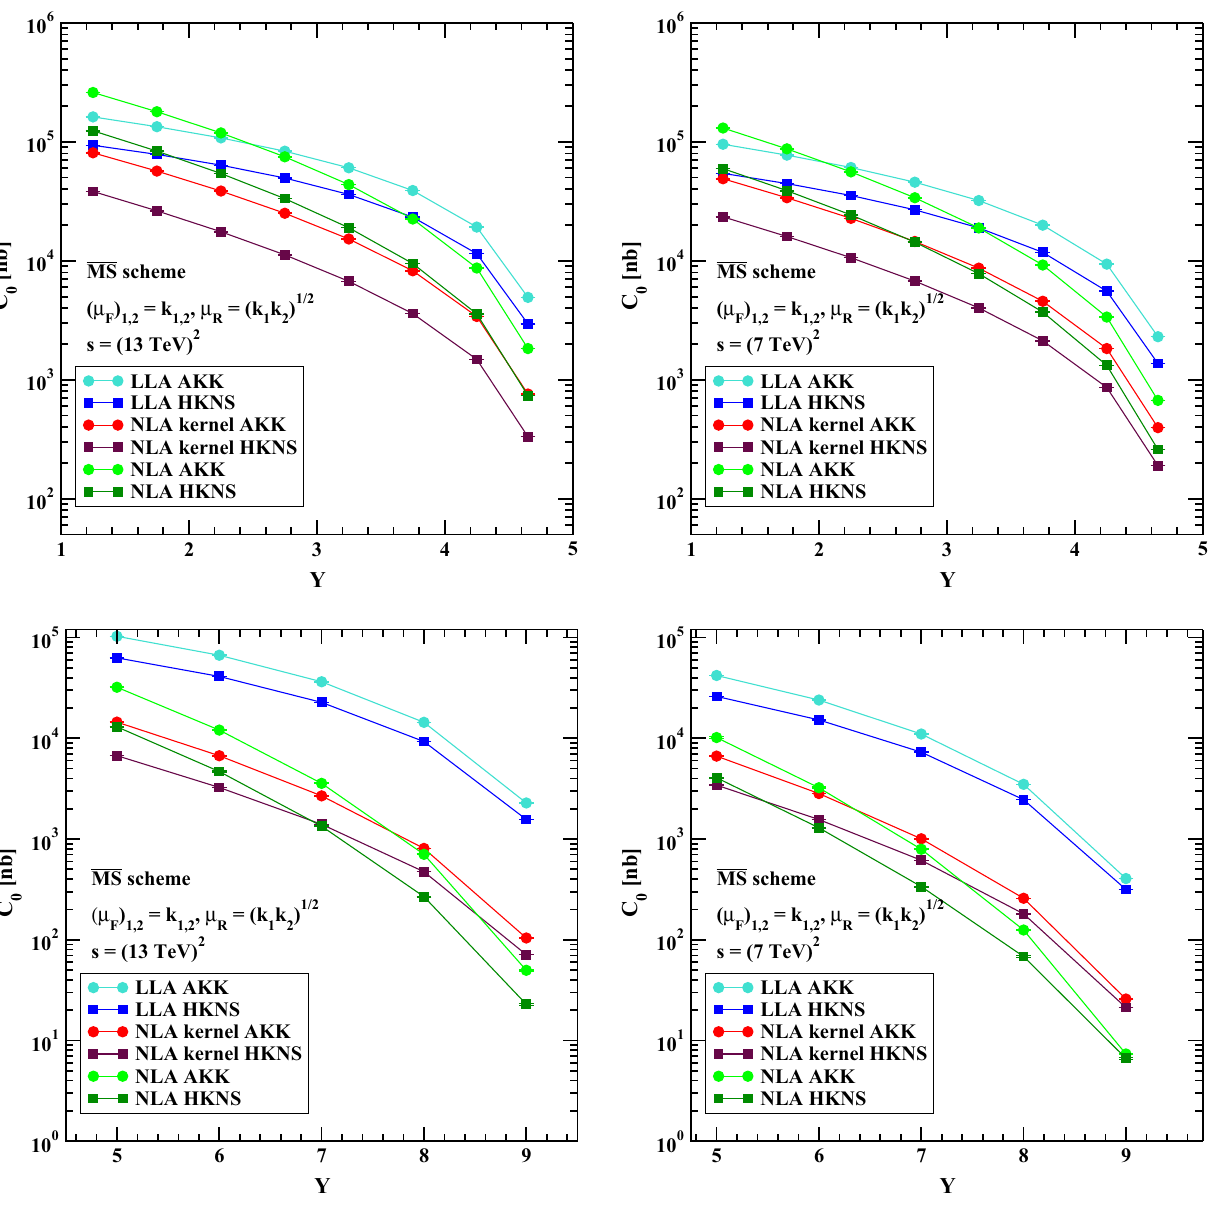
Fig. 3 Y -dependence of C 0 in the MS scheme (as implemented in Eq. (5)) at natural scales for μ R and μ F ,